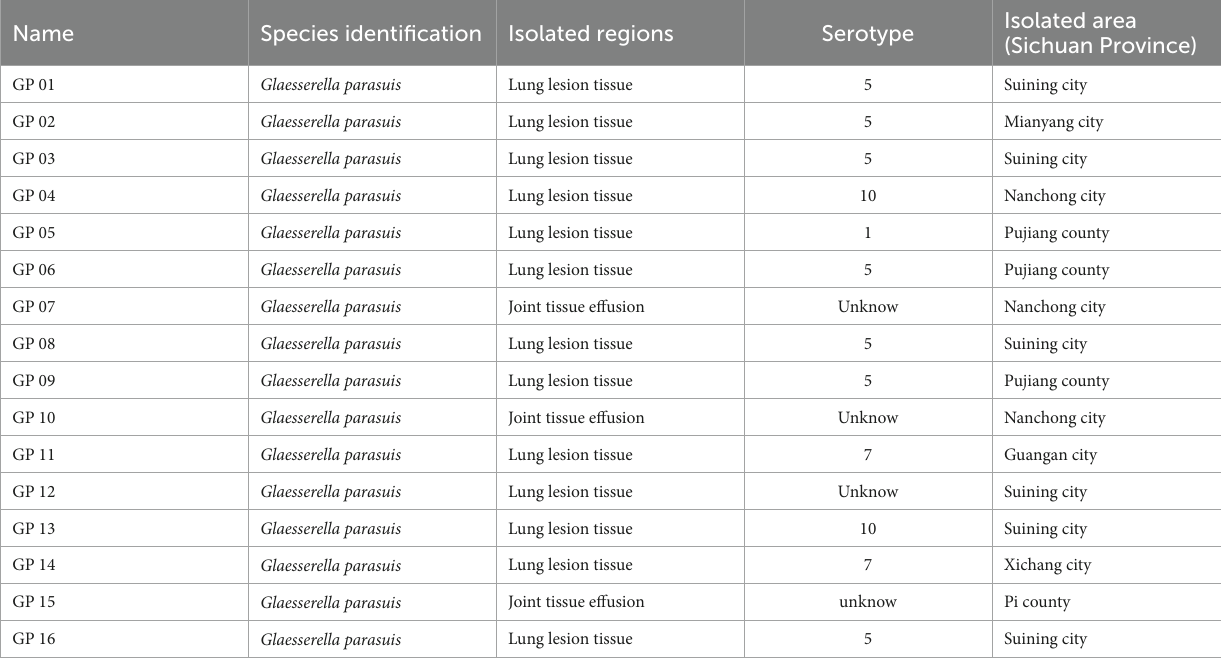
TABLE 1 The background information of G. parasuis isolates.